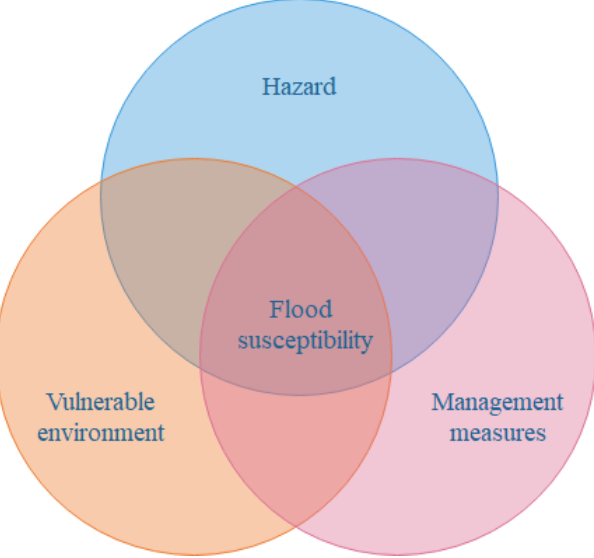
Figure 2. The cause and mechanism of flood susceptibility.